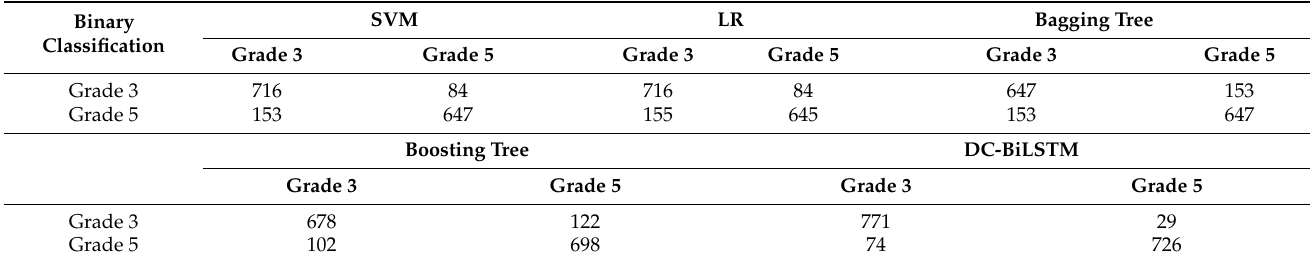
Table 9. Confusion matrices of classification algorithms—Malignant vs. Benign (external test set).